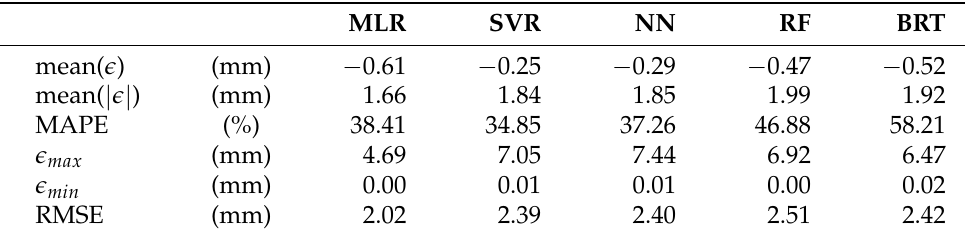
Table 5. Performance parameters for the MLP, SVR, NN, RF and BRT models regarding the predicted set.